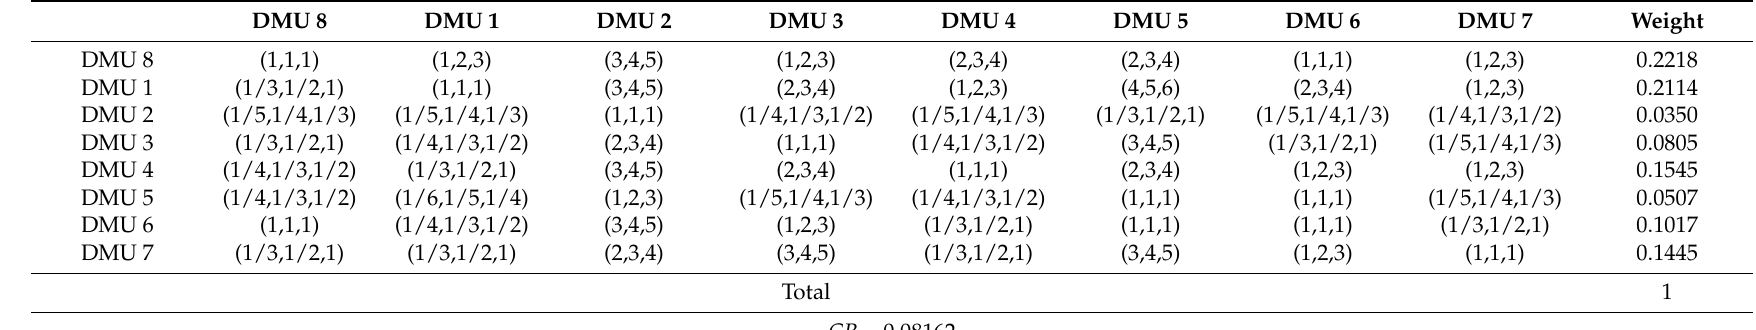
Table A29. Comparison matrix for OPM based on